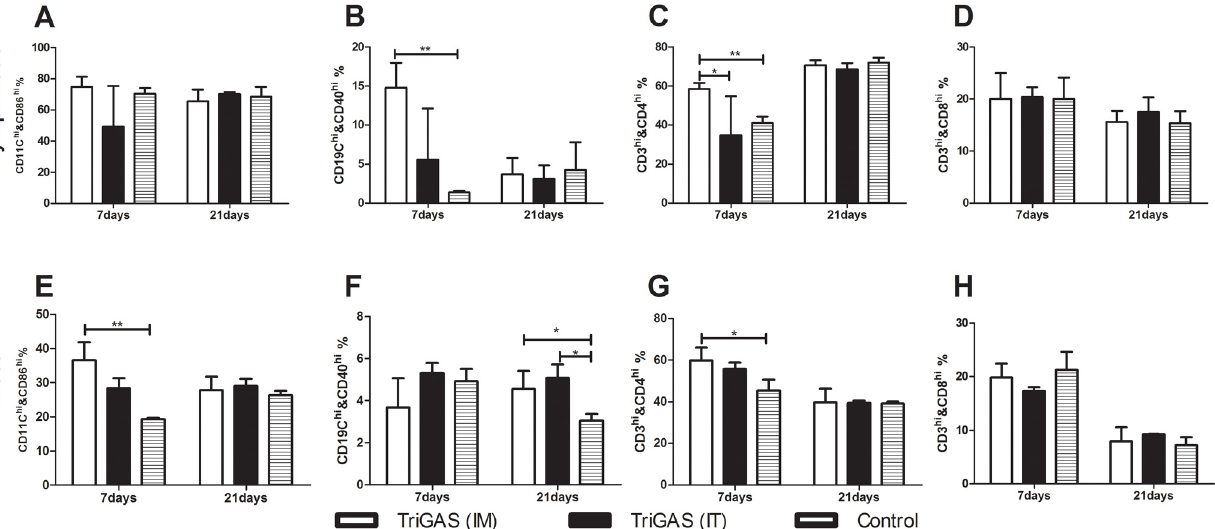
Fig 5. Comparison of cell-mediated immune responses to TriGAS by IM and IT route of immunization. Groups of dog were vaccinated with TriGAS via IM or IT route and compared the activation status of DCs and B-cells, and number of CD4 and CD8 T-cells in the lymph node (A-D) and in the blood (E-H).